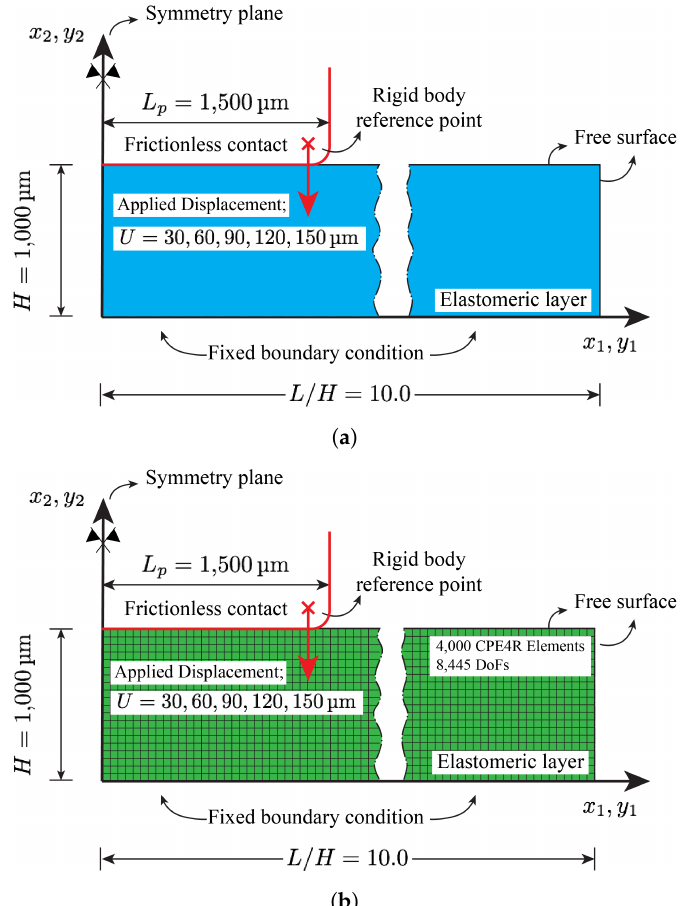
Figure 6. ( a ) The domain and associated boundary conditions used in carrying out the FE simulations; ( b ) The typical mesh used in FE